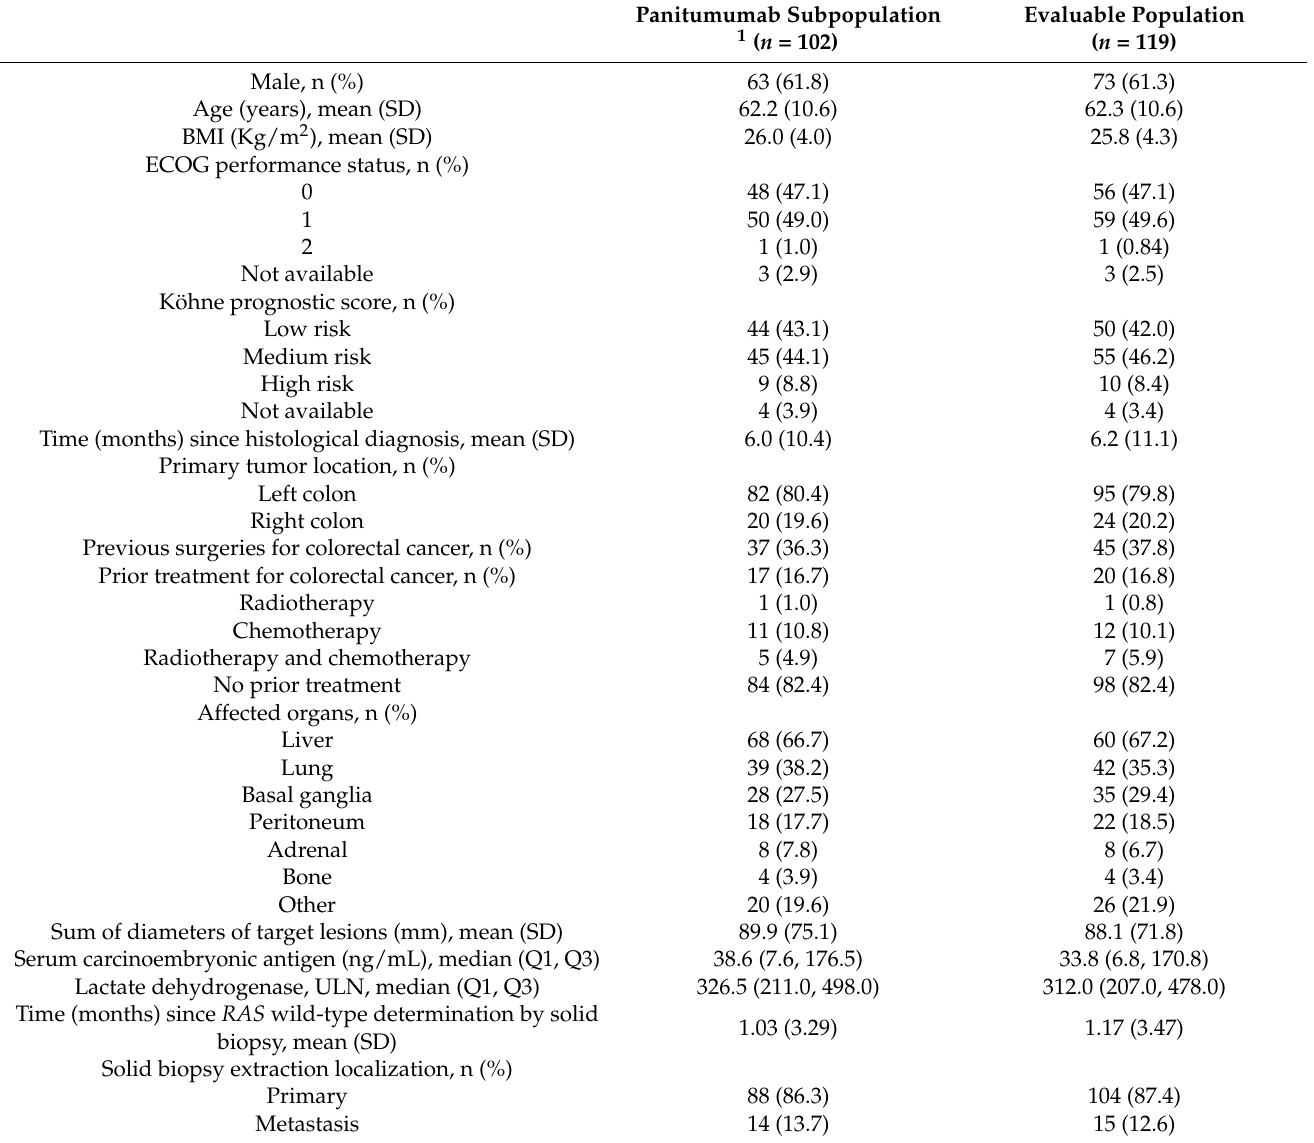
Table 1. Baseline demographic and clinical